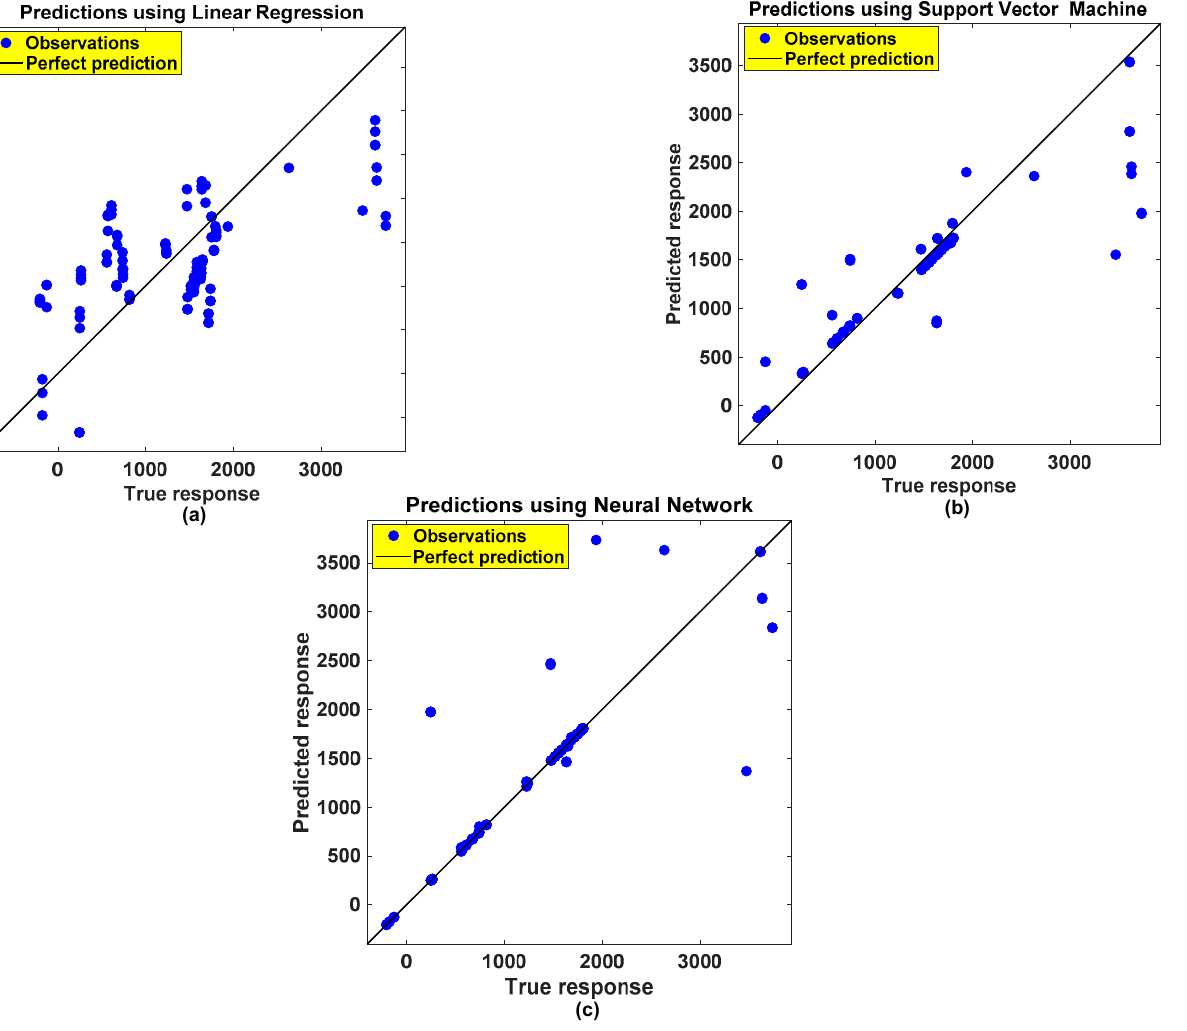
Figure 10. Plot fitting of predicted data and observations with ( a ) Linear Regression (quadratic), ( b ) Support Vector Machine, and ( c ) Artificial Neural Network models. Table 2. Comparison of performance metrics computed for LR (quadratic), SVM, ANN, and LSTM.